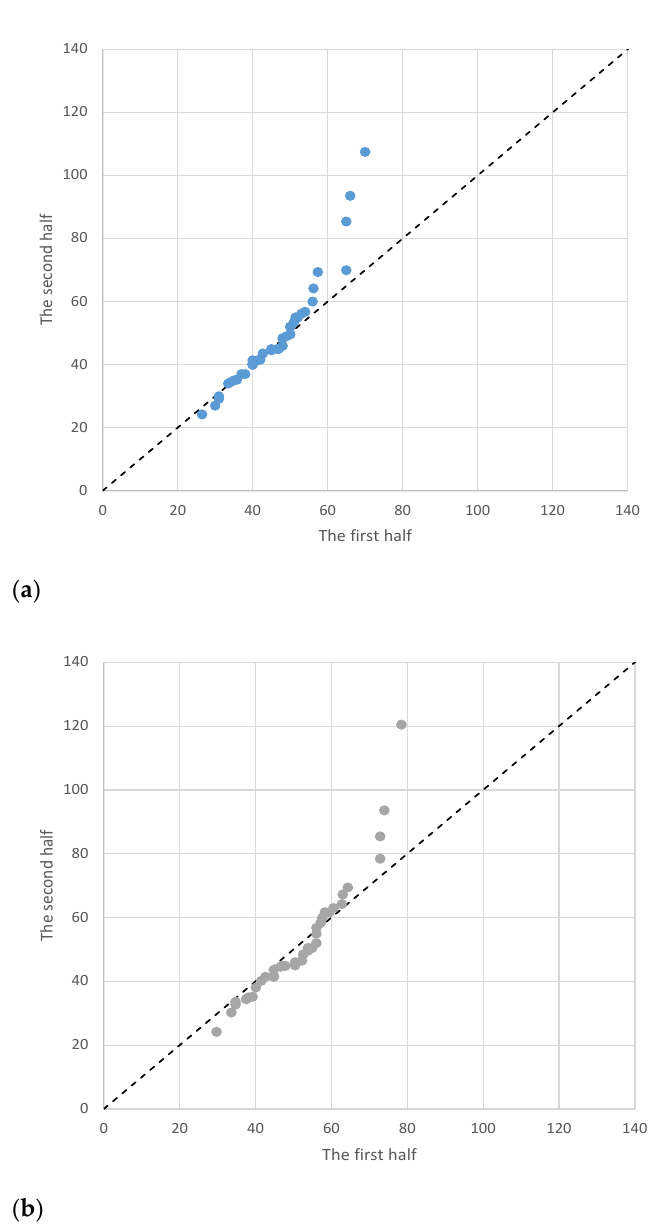
Figure 7. Trend conditions according to Sen’s method for the annual maximum rainfall depths for Norcia station and duration equal to 24 h: ( a ) “uncorrected” series; and ( b ) “corrected” series. Available data within the period 1921–2019.